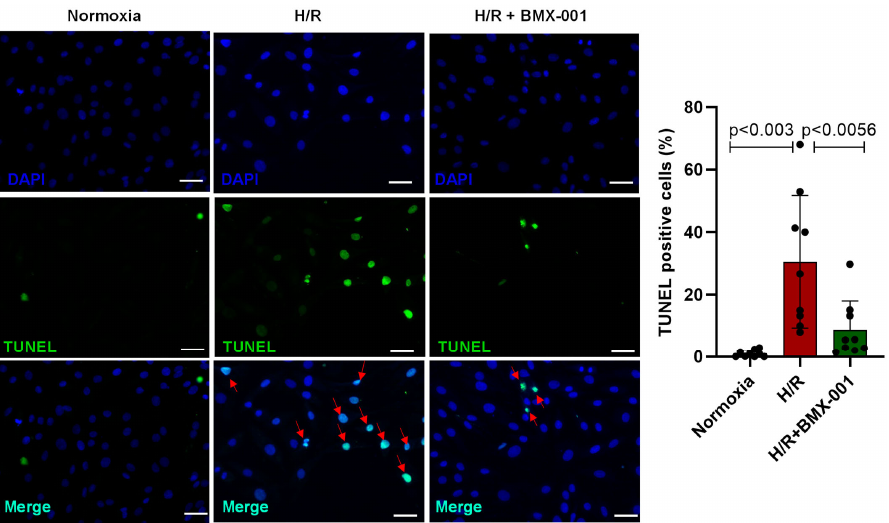
Figure 5. Redox regulator, BMX-001, SOD2 mimetic a tt enuated apoptosis following H/R injury in H9c2 cells. Apoptosis was determined by TUNEL assay (magni fi cation ×20). The % of